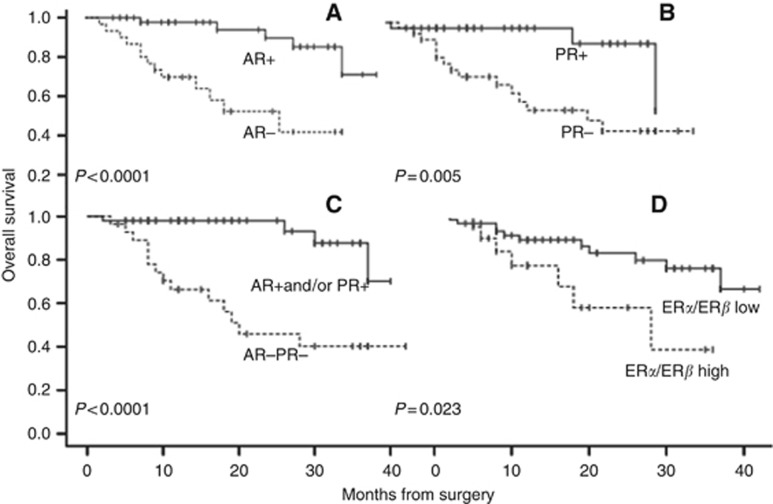
Kaplan–Meier survival curve for the probability of disease-free period relative to immunoexpression of (A) AR, (B) PR, (C) AR/PR negative and (D) ERα/ERβ ratio.